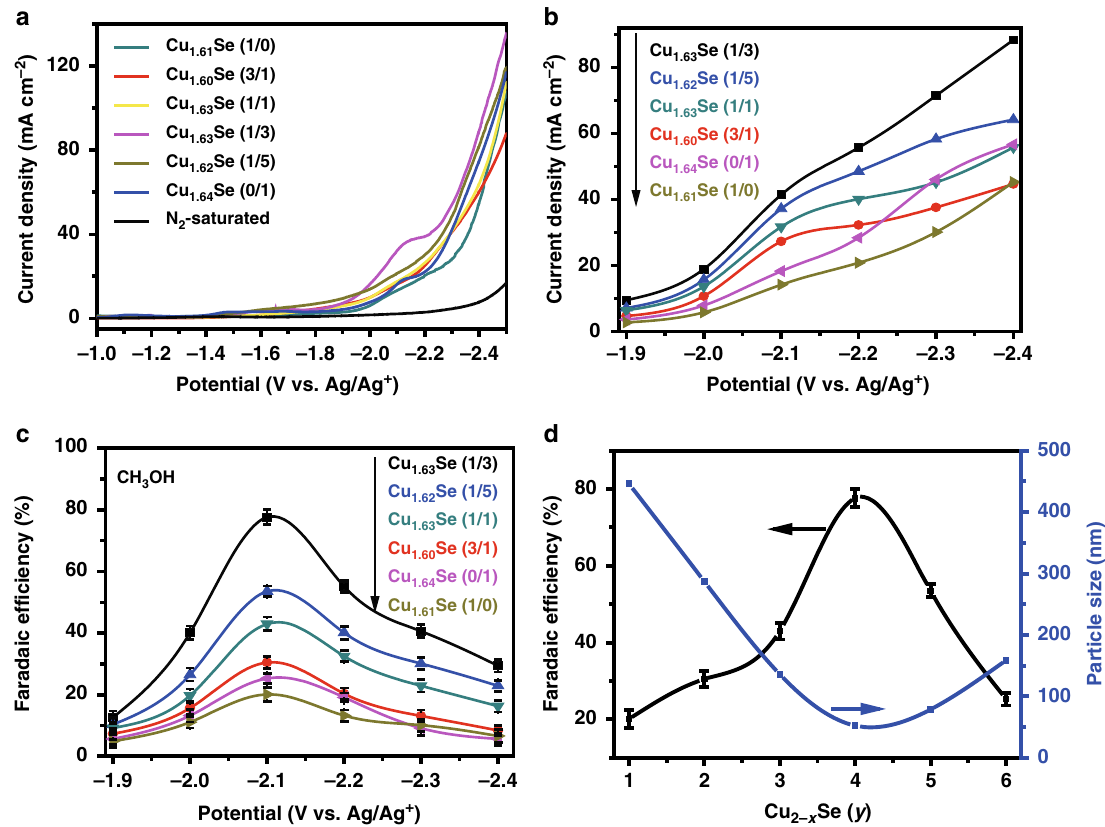
Fig. 2 CO 2 reduction performance on Cu 2 − x Se( y ) nanocatalysts. a LSV traces on different electrodes in CO 2 -saturated or N 2 -saturated electrolyte at scan rate of 20 mV s − 1 ; b Total current density and c FE over Cu 1.63 Se(1/3) catalyst at different applied potentials; d Plots of particle size vs. FE of methanol on different catalysts (1) Cu 1.61 Se(1/0); (2) Cu 1.60 Se(3/1); (3) Cu 1.63 Se(1/1); (4) Cu 1.63 Se(1/3); (5) Cu 1.62 Se(1/5); (6) Cu 1.64 Se(0/1). Data were obtained at ambient temperature and pressure with CO 2 stream of 10 sccm with 5 h electrolysis. All data in c and d are presented as mean ±